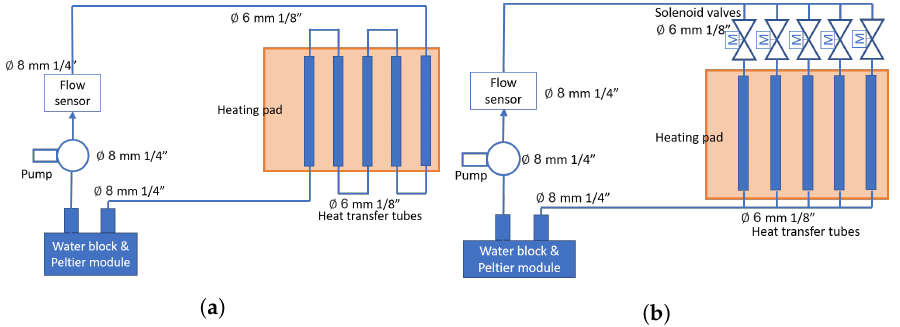
Figure 5. P & ID of cooling systems. ( a ) P & ID of continuous system; ( b ) P & ID of discontinuous